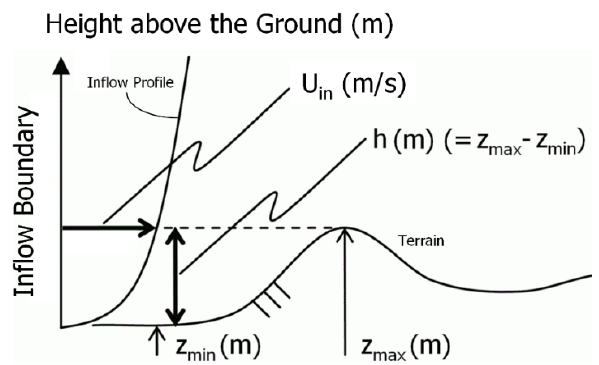
Figure 11. Two characteristic scales ( U in and h ).